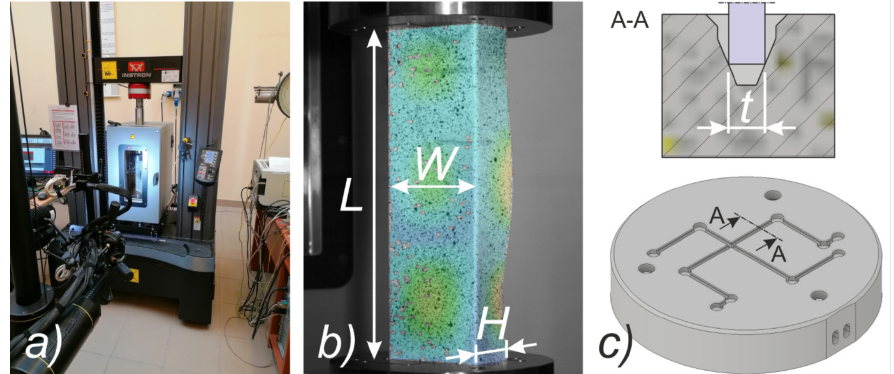
Figure 2. The test stand ( a ) with the considered channel section profile ( b ) and elements for column positioning ( c